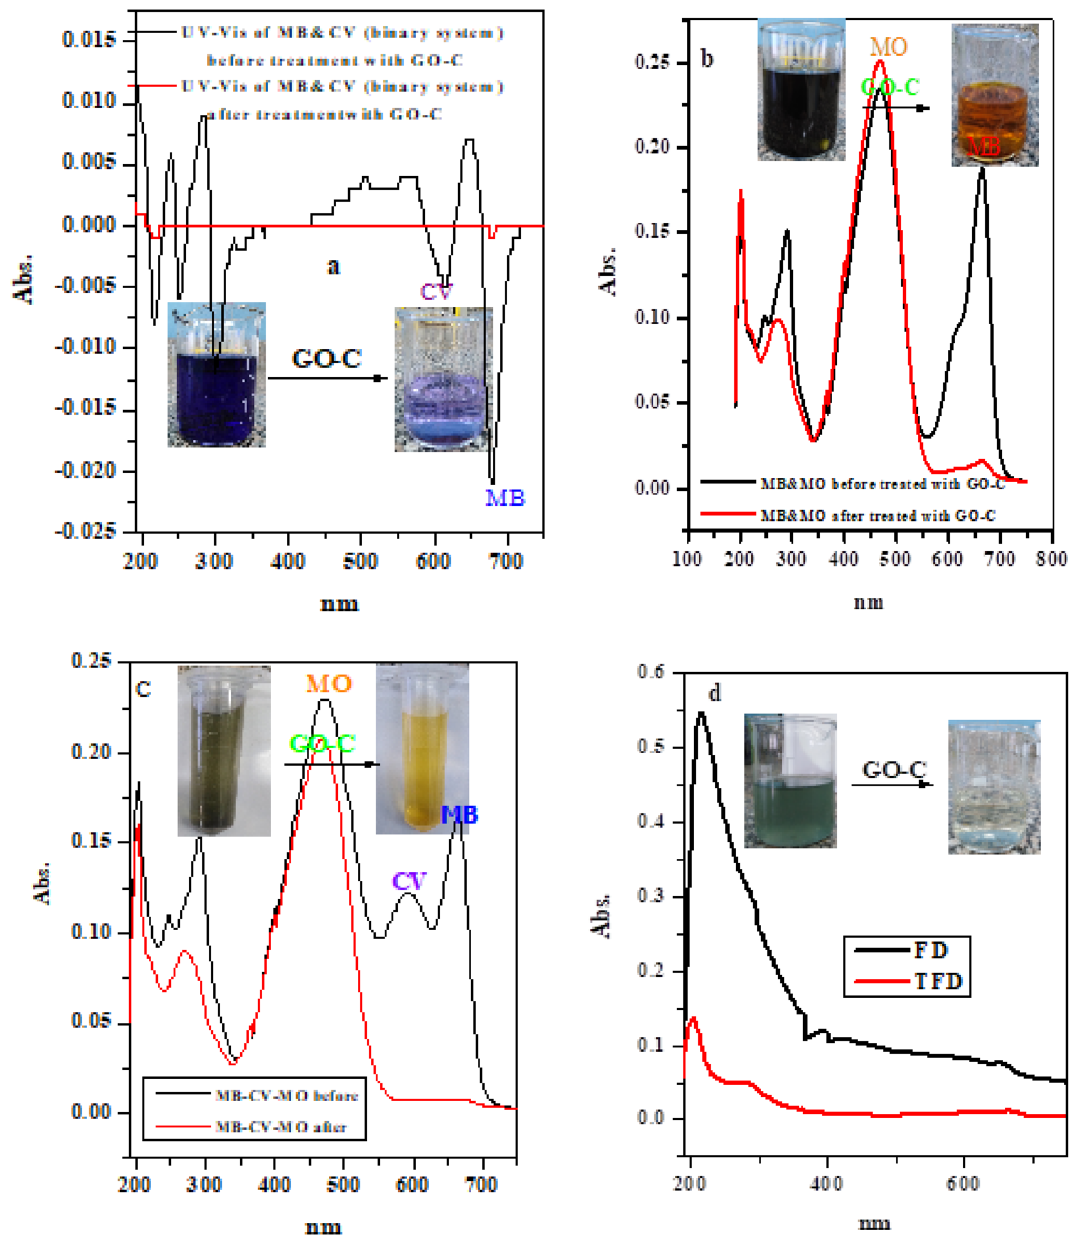
Figure 9. UV–Vis spectra of; ( a ) (MB–CV) binary system solution before and after treated with GO–C composite, ( b ) (MB–MO) binary system solution before and after treated with GO–C composite, ( c ) (MB–CV– MO) trinary system solution before and after treated with GO–C composite and ( d ) factory real sample (FD) and treated factory real sample